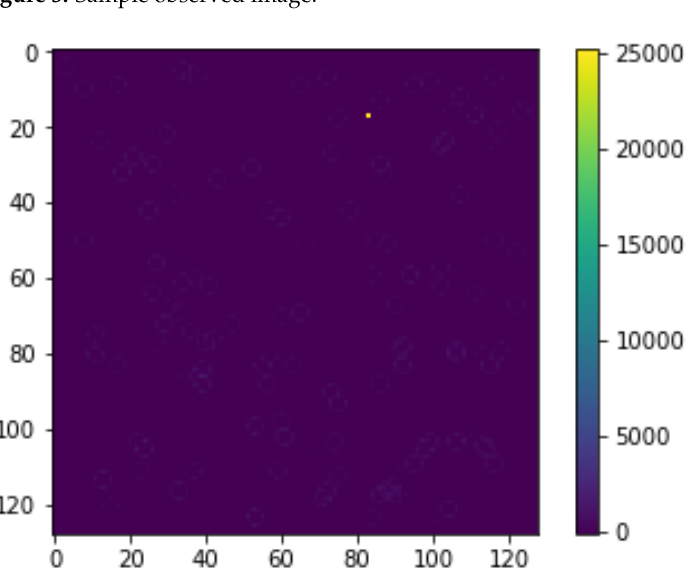
Figure 3. Sample observed image.